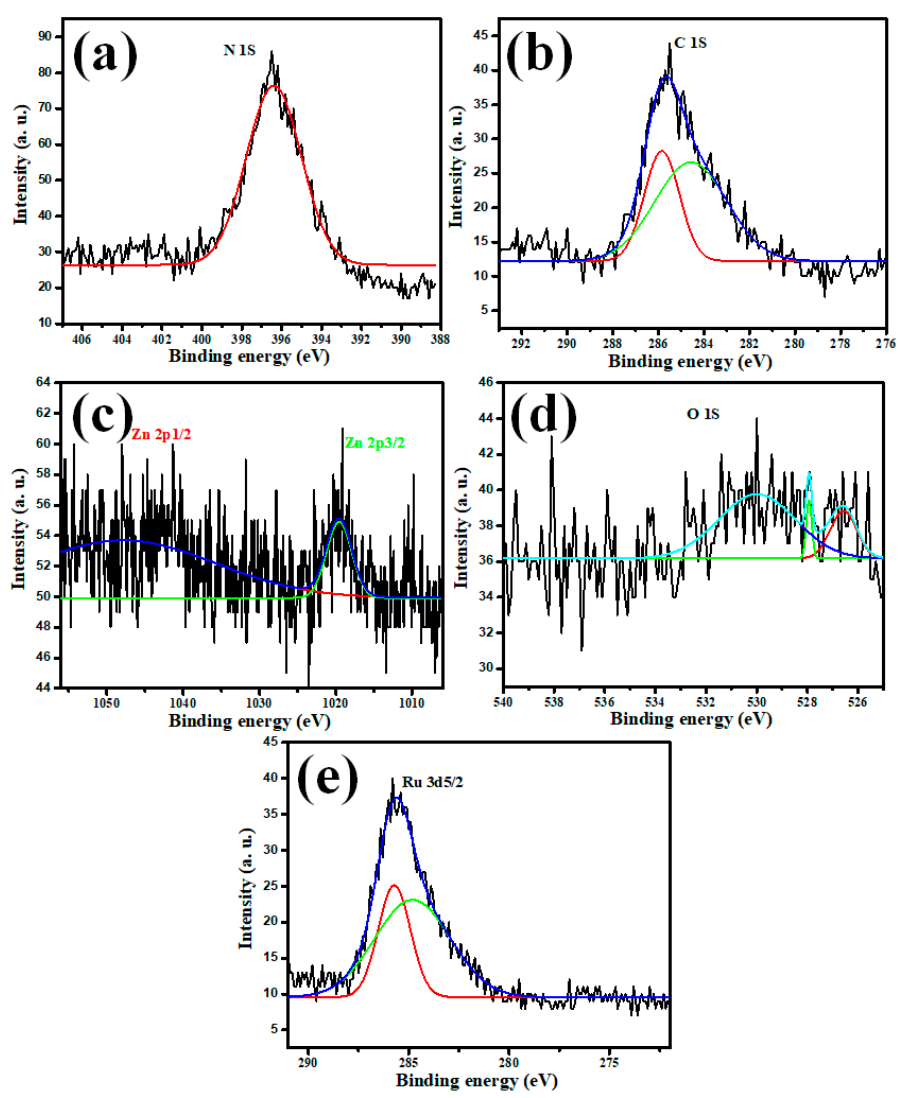
Figure 5. XPS analysis of ( a ) N 1s, ( b ) C 1s, ( c ) Zn 2p, ( d ) O1s, and ( e ) Ru 3d elemental for Ru-ZnO-g- C 3 N 4